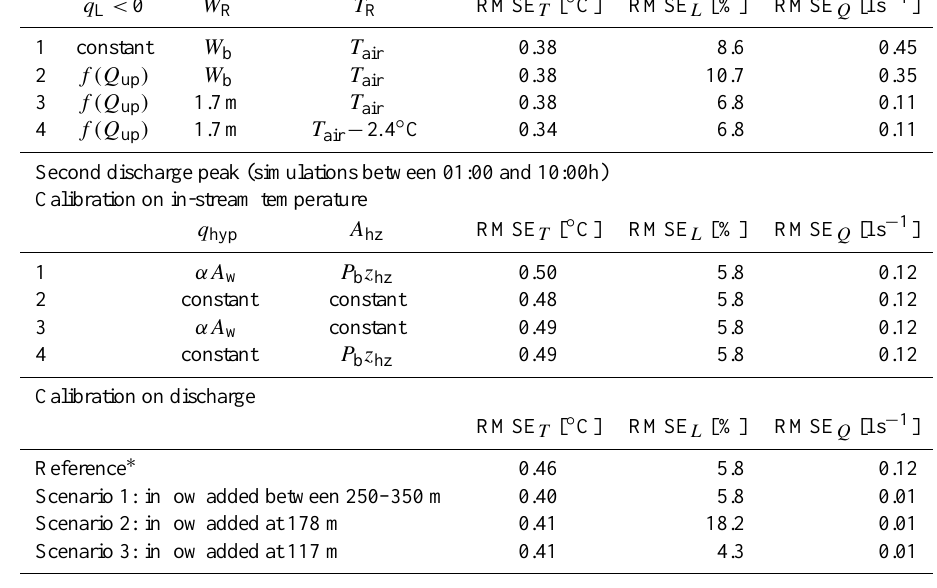
Table 1. Overview of calibration parameters for each step, with corresponding RMSE values. First discharge peak (simulations between 20:40 and